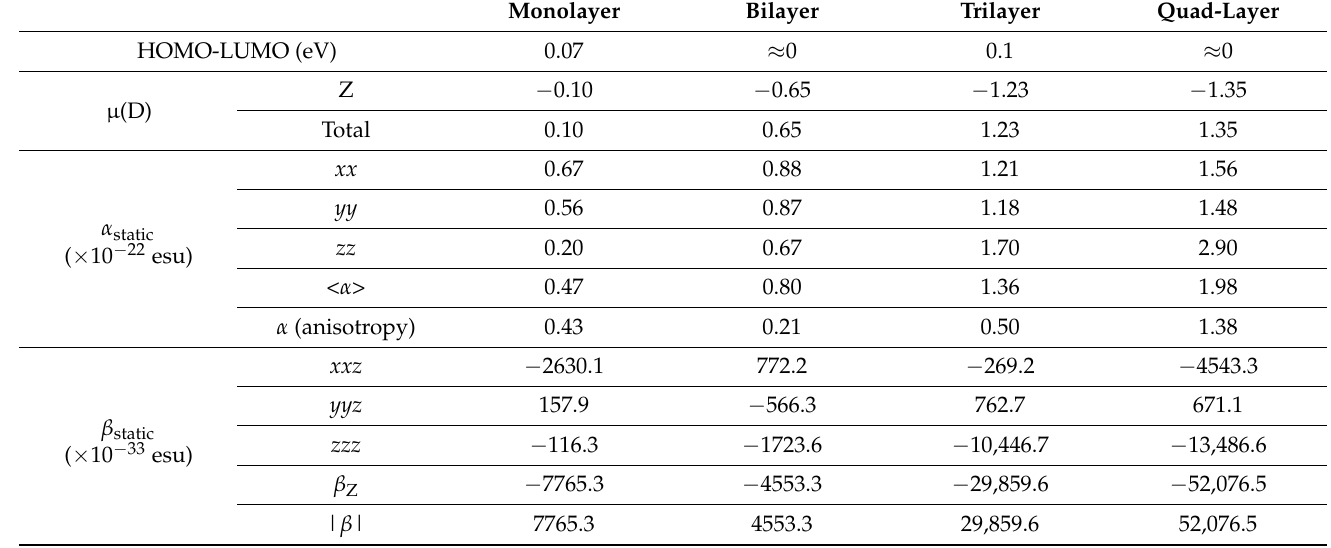
Table 2. The dipole moment and static (hyper) polarizabilities of monolayer, bilayer, trilayer, and quad-layer nanoflakes of Borophene calculated with PBE + D2 functional using 6–31 G basis sets. α and β are the polarizability and the first- hyperpolarizability,